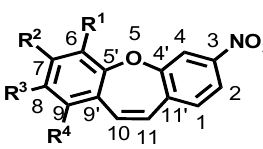
Table 3. Carbon-13 chemical shifts for 3-nitrodibenzo[ b , f ]oxepine, substituent-induced chemical shifts for its methoxy substituted derivatives.